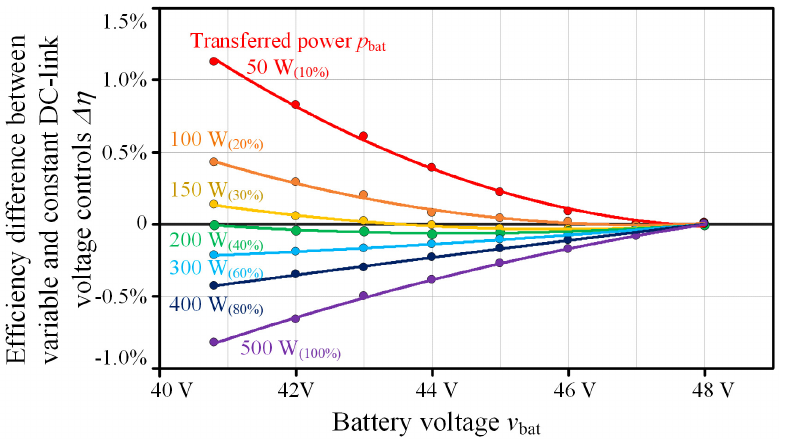
Figure 12. Power conversion efficiency difference between variable and constant DC-link voltage controls.